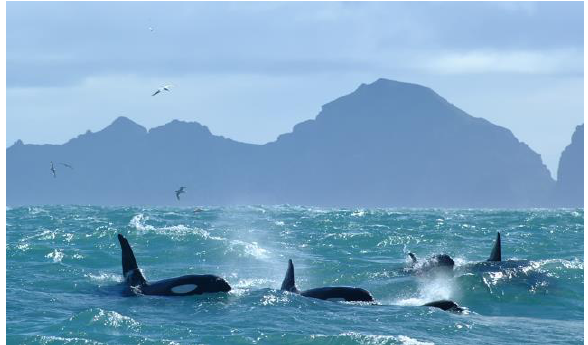
Figure 1. Killer whales off the Vestmannaeyjar, Iceland. Photo credit: Fernando Ugarte.